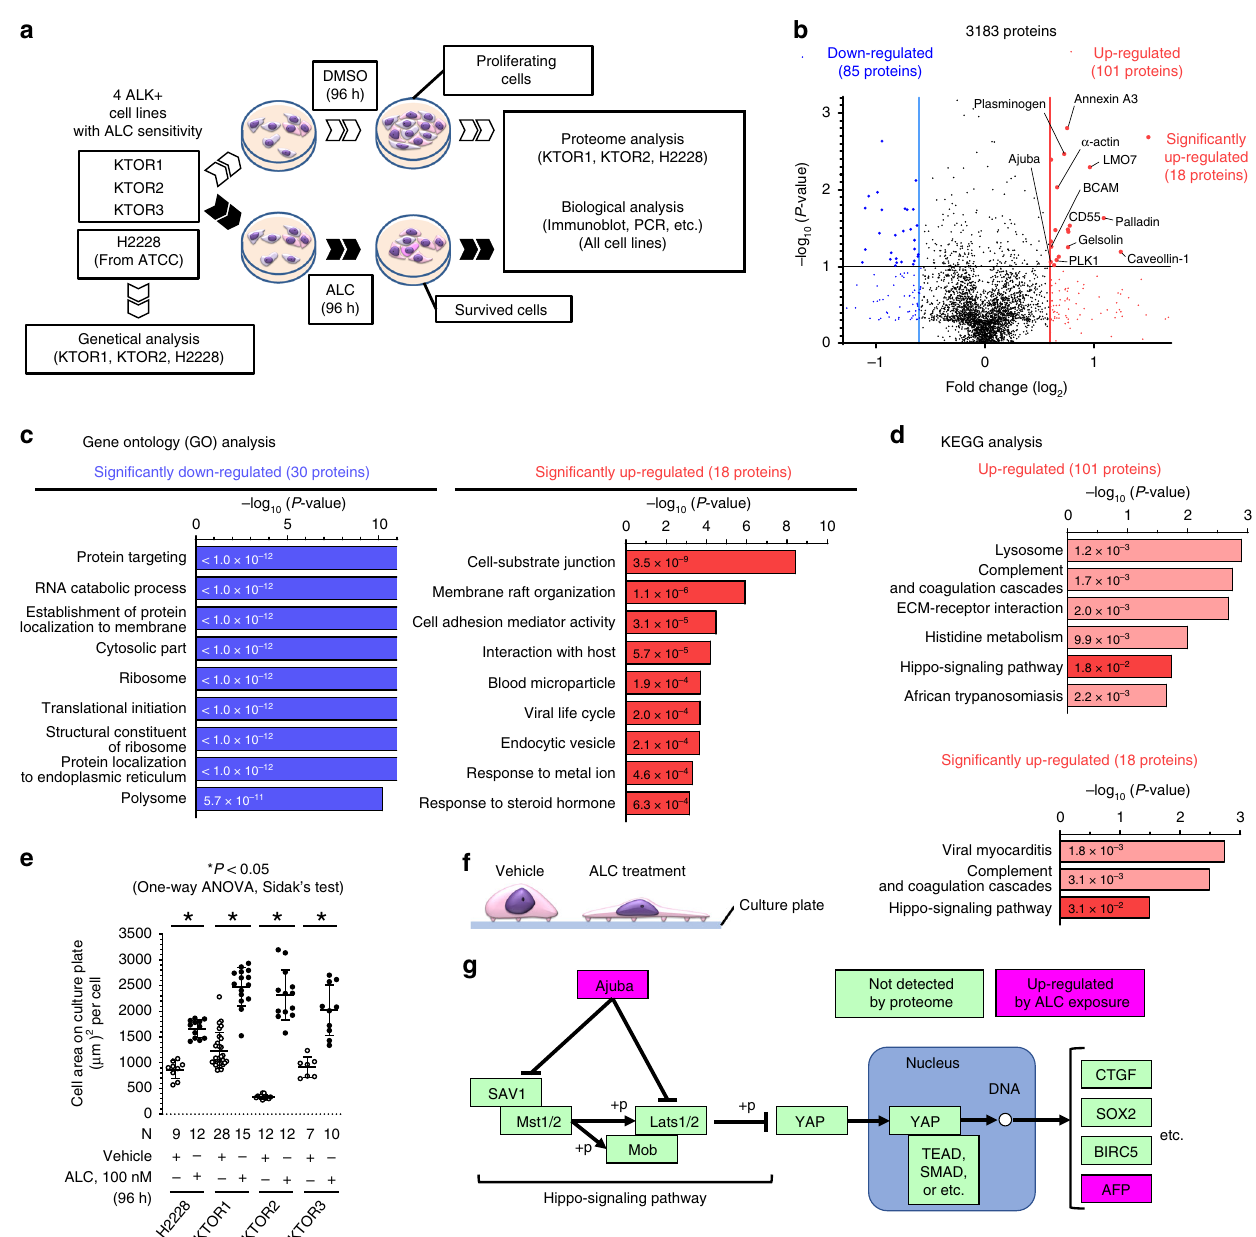
Fig. 2 Proteome analysis to identify acute response of ALK-rearranged cells to ALC. a A schematic explanation of the experiment to identify the acute response of ALK-rearranged cells to alectinib. Four ALK-rearranged NSCLC cells with alectinib sensitivity were exposed to DMSO or the survivable inhibitory concentration (sIC) of ALC (see Table 1) for 96 h. Proteome and conventional biological analyses were performed to compare cells that survived ALC and proliferating control cells (DMSO-treated). b The integrated results of the proteome analysis in ALK-rearranged cell lines ( n = 3 biologically independent cell lines, KTOR3 was excluded, please see the text). Volcano plot representing all expressed proteins. Regarding every protein, fold changes in the vehicle and exposure to alectinib were plotted against the – log P -value. The integrated P -value was calculated by paired t-test. Signi fi cant differentially expressed proteins, with a fold change ≥ 1.5 or ≤ − 1.5, are depicted as red or blue, while insigni fi cant ones are shown as black dots. Of the 3183 proteins detected after the 96-h exposure to alectinib, 48 were differentially expressed (18 up- and 30 downregulated). c Gene ontology (GO) analysis of the 48 proteins. P -values were calculated using Fisher ’ s test. d KEGG pathway analysis on the upregulated proteins. P -values were calculated using Fisher ’ s test. All annotated pathways are presented. e Average cell area on the culture plate. A plot shows the average cell area on each photographed image. Signi fi cance was evaluated using a one-way ANOVA followed by Sidak ’ s multiple comparison test. f Cell adhesion areas in culture plates increased when ALK-rearranged cells were treated with ALC. g A simpli fi ed diagram of the Hippo signaling pathway using KEGG pathway analysis. Two important factors (Ajuba, AFP) among the four annotated proteins are shown. All analysis results are described in Supplementary Data 2. * P < 0.05. ALK anaplastic lymphoma kinase, NSCLC non-small cell lung cancer, ALC alectinib, DMSO dimethyl sulfoxide. Error bars indicate ±